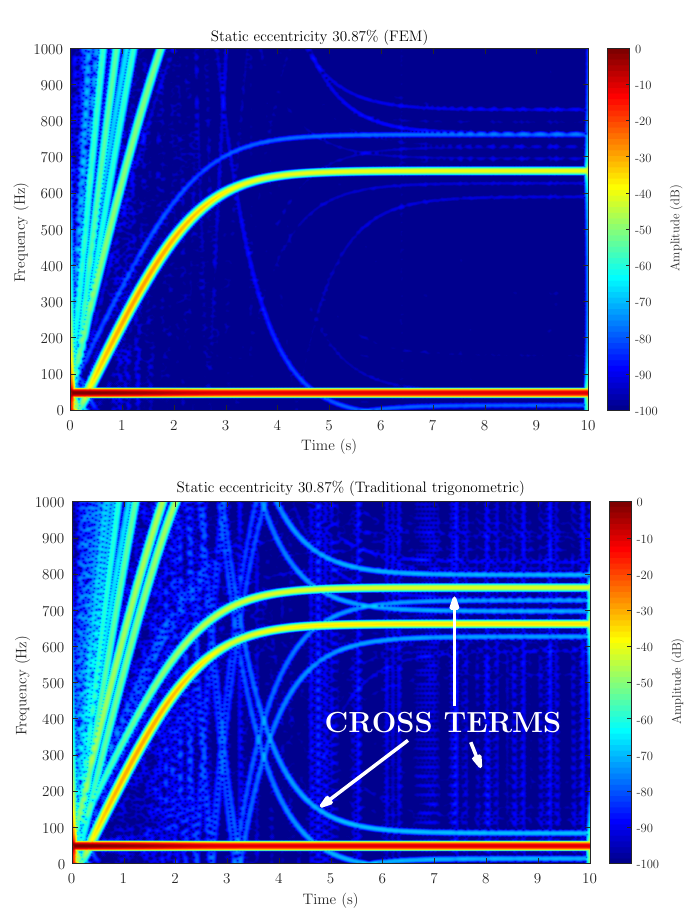
Figure 11. Stator current spectrogram for static eccentricity level 30.87% using FEM ( top ) and traditional trigonometric interpolation polynomial ( bottom ). Traditional trigonometric interpolation polynomial introduces cross terms in the post-processing that could lead to